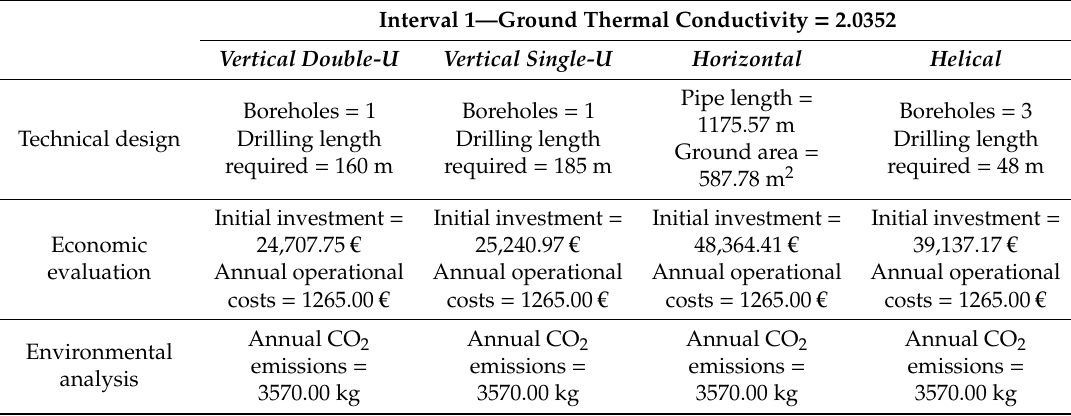
Table 5. Design provided by GES-CAL software for the geothermal system under study, interval 1.